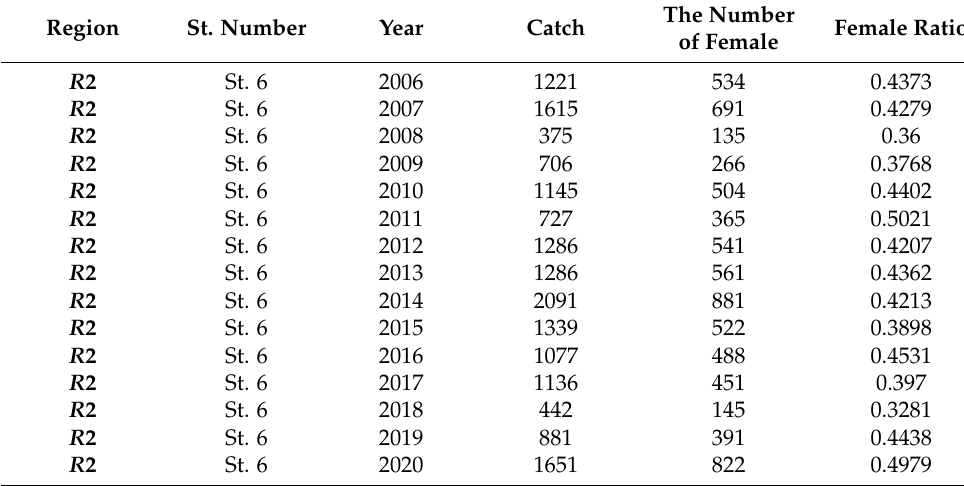
Table A2. Cont. Region St. Number